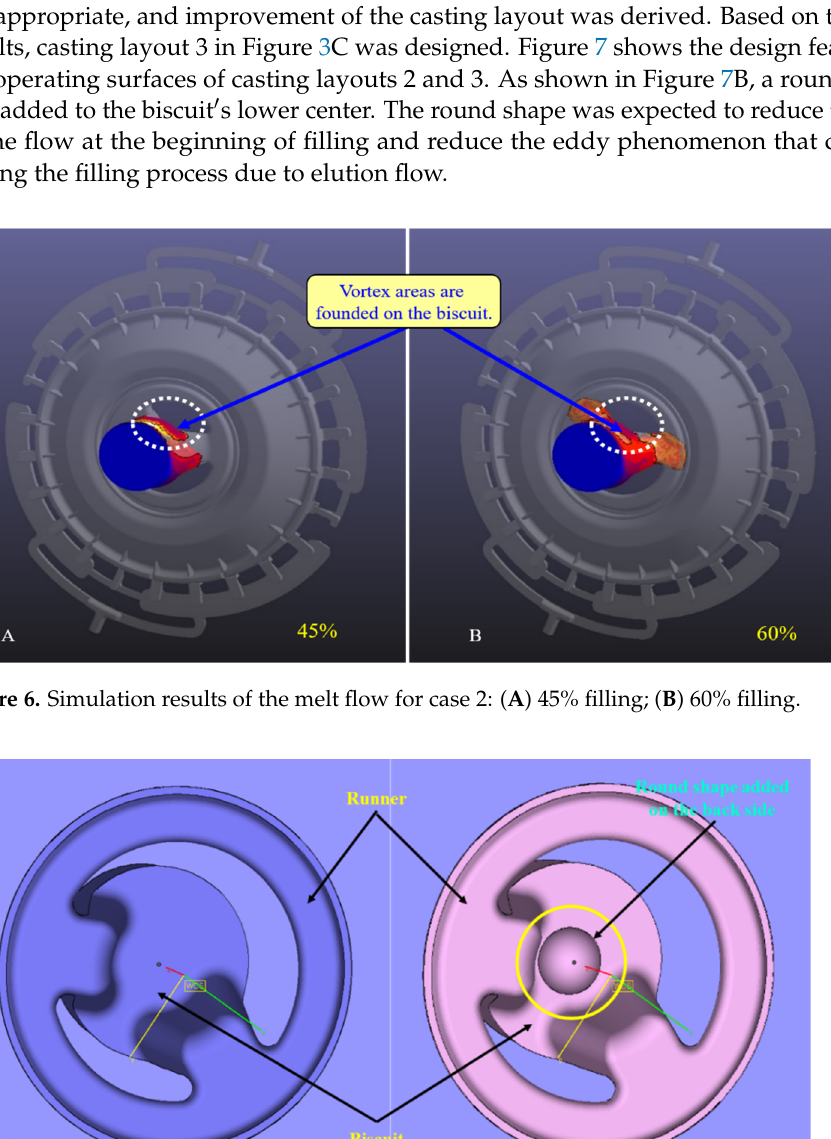
Figure 5. Simulation results of the melt flow: ( A ) 96% filling of case 1; ( B ) 96% filling of case 2.